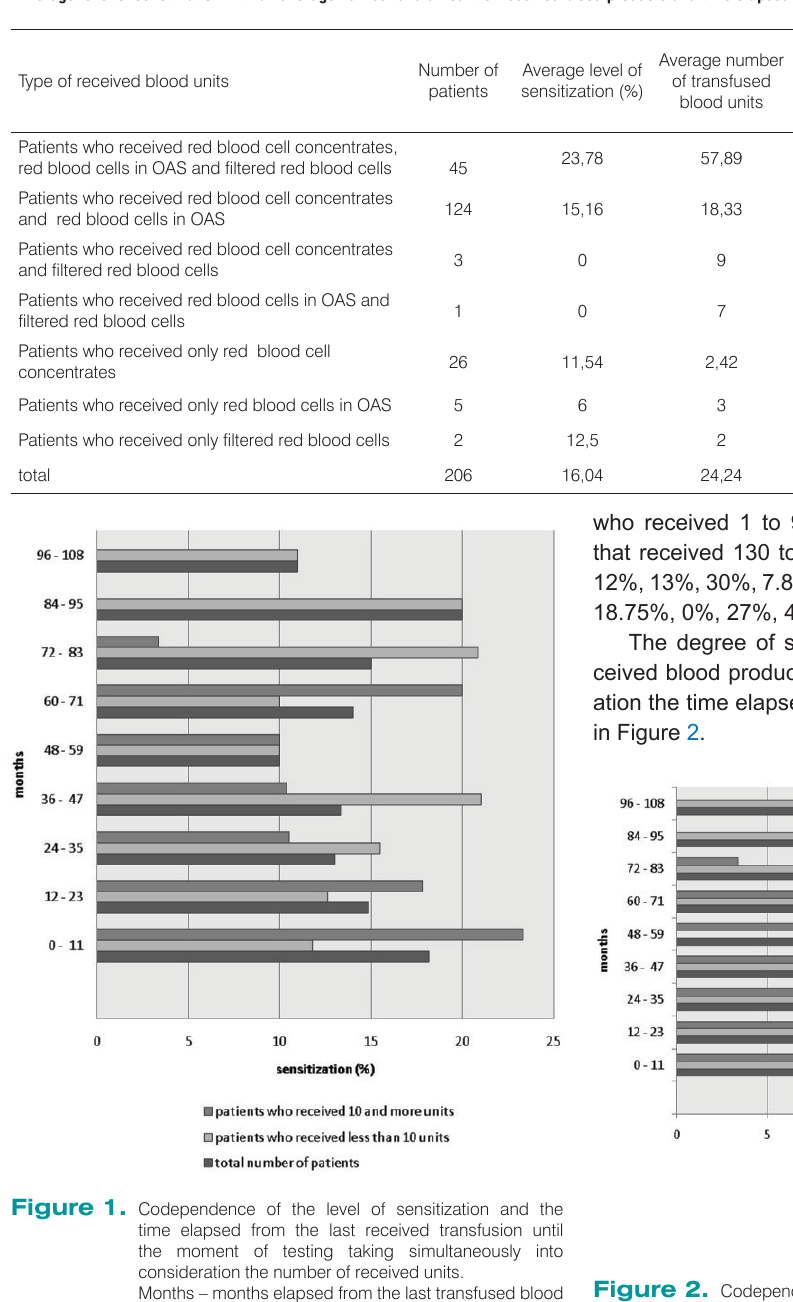
Figure 1. Codependence of the level of sensitization and the time elapsed from the last received transfusion until the moment of testing taking simultaneously into consideration the number of received units. Months – months elapsed from the last transfused blood product until the moment of testing. Sensitization (%) - average level of sensitization expressed in percentages